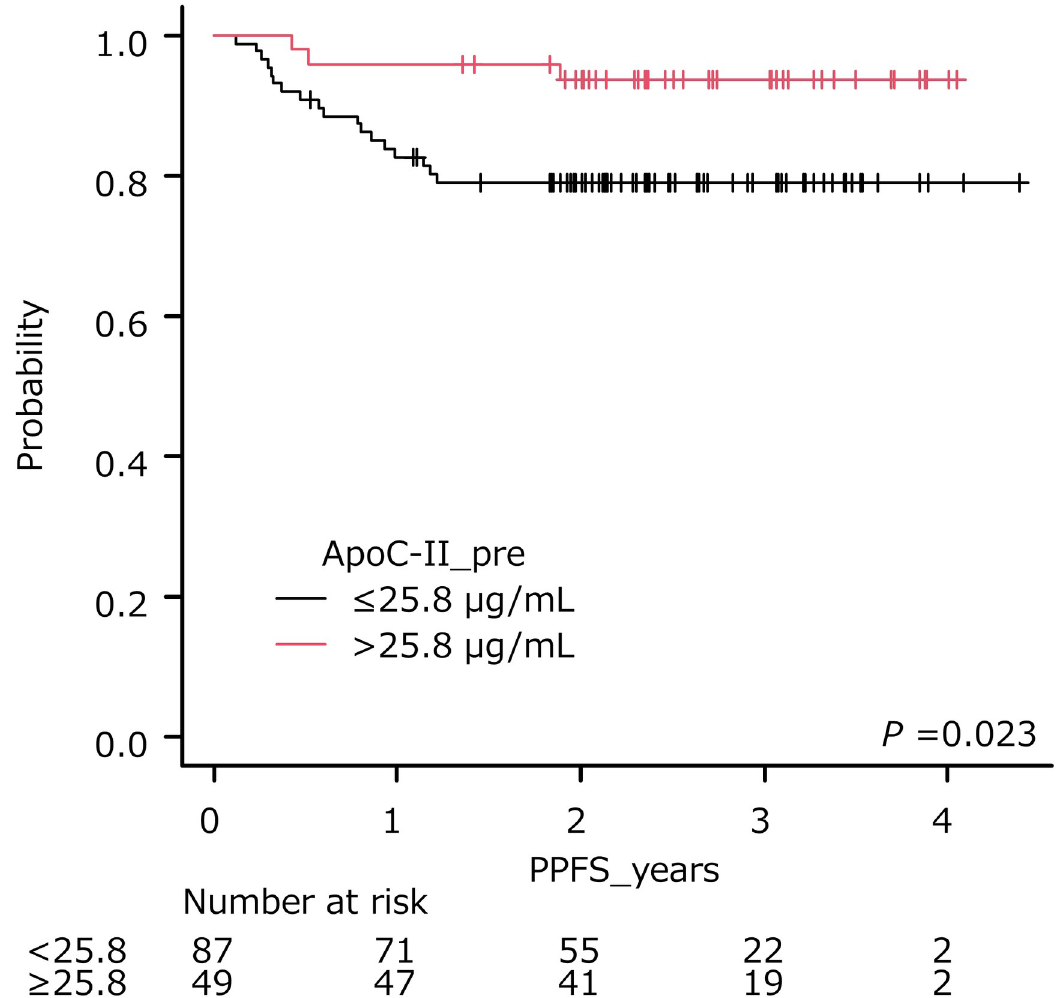
Fig 4. Pelvic progression-free survival of patients stratified by pretreatment ApoC-II levels. Lower levels of pretreatment ApoC-II ( � 25.8 μ g/ml) were significantly associated with poorer outcome ( P = 0.023).